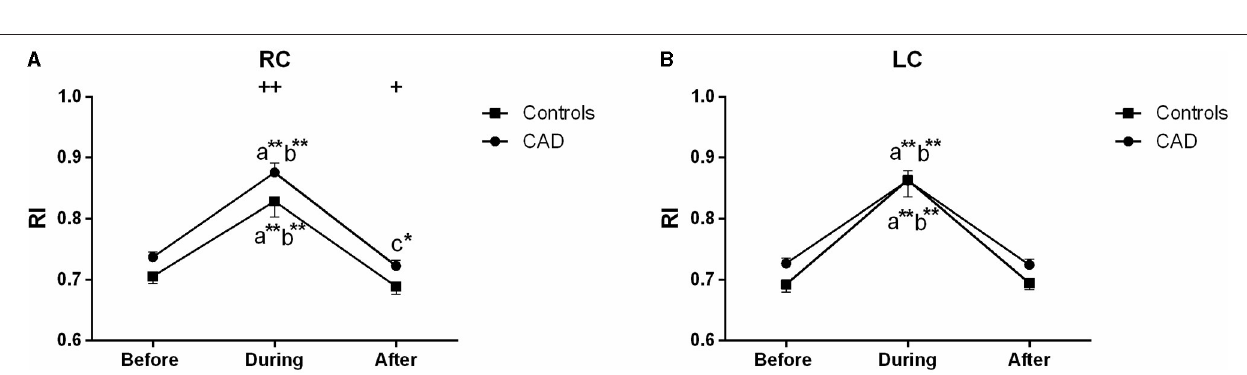
FIGURE 5 | Effect of EECP on the end-diastolic velocity (EDV) of RC and LC (A,B) , RB (C) , and RF (D) in the patients with CAD and controls before, during, and after a 45 min-EECP. a indicates significant differences in measurements obtained during EECP vs. pre-EECP; b indicates differences between post-EECP vs. during-EECP. ** and ++ denote p -values < 0.01 of the difference between groups.